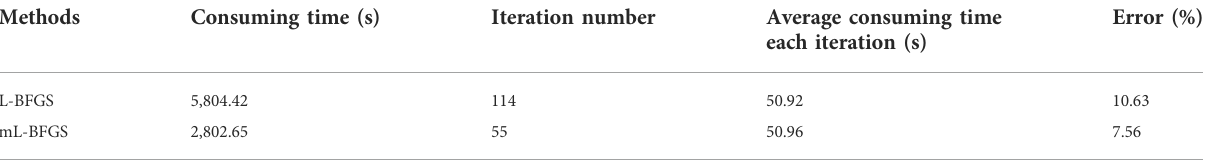
TABLE 1 Comparison between L-BFGS and mL-BFGS in FWI with noise-free